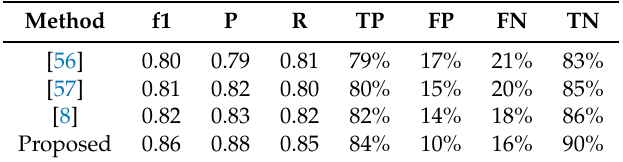
Table 10. Quantitative comparison with some state-of-the-art